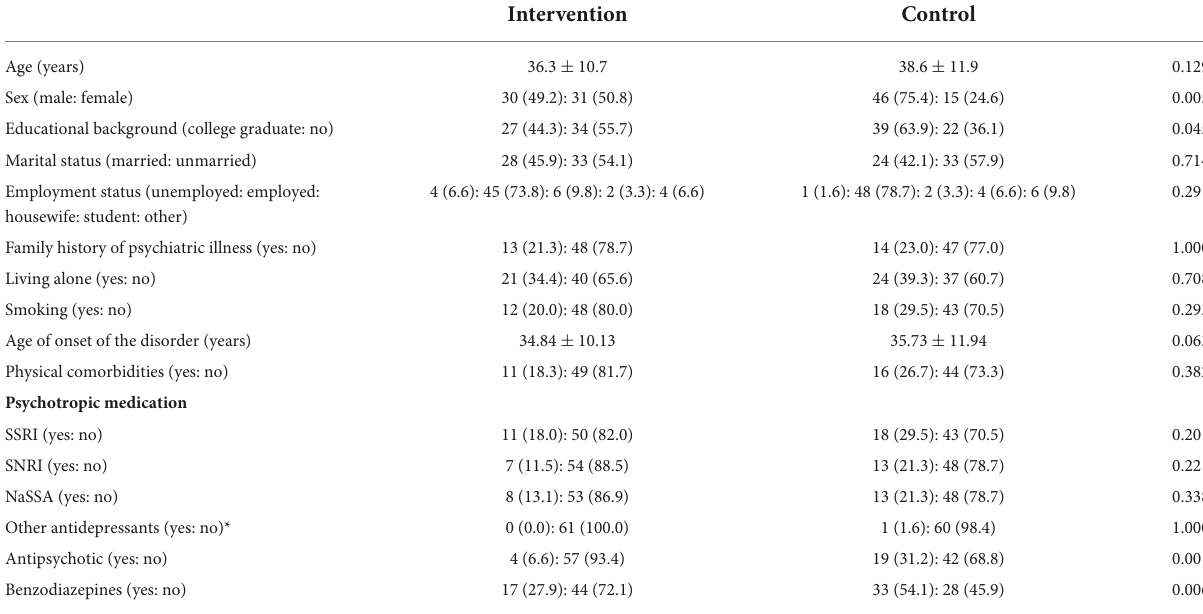
TABLE 1 Characteristics of study participants.